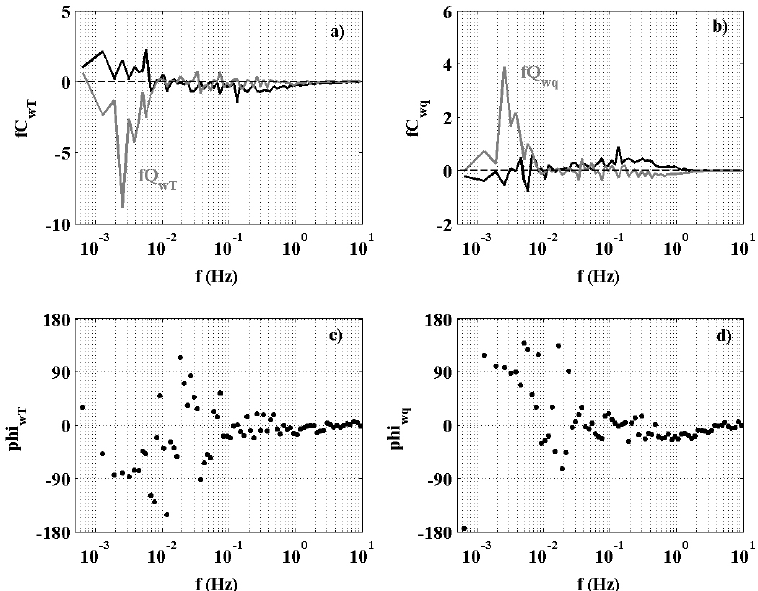
Figure 5. Cospectra (black lines) and quadrature spectra (grey lines) for the w-T cross-spectrum ( a ) and the w-q cross-spectrum ( b ); phase spectra for the w-T cross-spectrum ( c ) and the w-q cross-spectrum ( d ) versus the natural frequency ( f ) relative to the time series shown in Figure 2 and sampled at the highest level (10